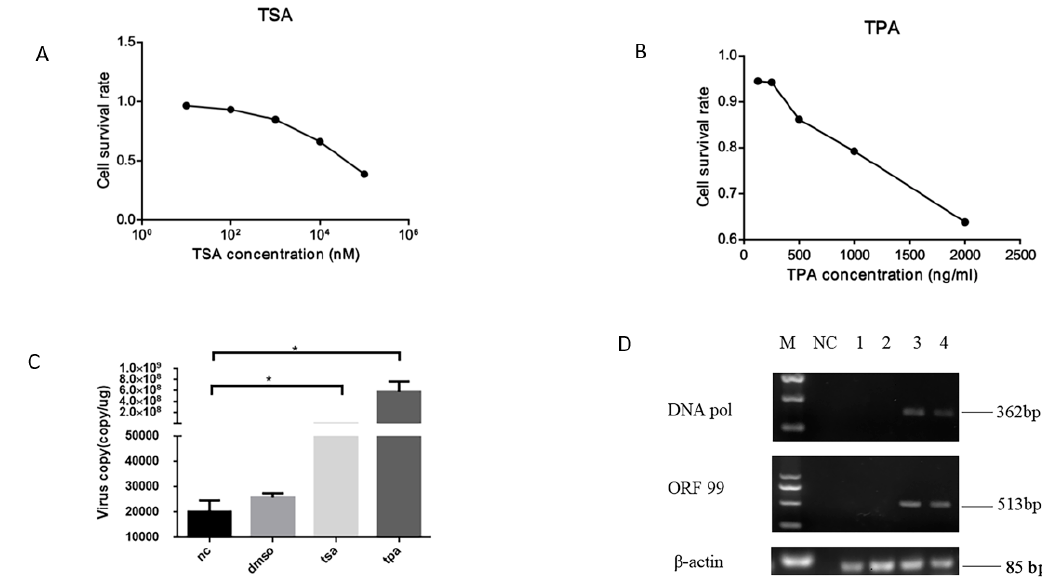
Figure 5. Examination of CyHV-2 DNA and gene transcription in GCBlat1 cells upon chemicals treatment: Cell viabilities of GCBlat1 cells were measured by an MTT assay following treatments with trichostatin A (TSA) ( A ) or phorbol 12-myristate 13-acetate (TPA) ( B ) (80, 40, 20, 10, and 5 µ M) or dimethyl sulfoxide (DMSO) for 48 h. ( C ) qPCR analysis of the CyHV-2 DNA from GCBlat1 cells with TSA, TPA, DMSO, or without treatment (nc). CyHV-2 DNA copies were calculated similarly as described above. Data presented as the mean ± SD ( n = 3). ( D ) RT-PCR analysis of total RNA harvested from treated and untreated GCBlat1 cells: The amplicons of DNA pol (362 bp) and ORF99 (513 bp) are indicated. The amplicons of β -actin gene are used as an internal control to ensure that comparable levels of input RNA were used in RT-PCR. M: DNA ladder; NC: negative control for PCR; lane 1: mock-treated GCBlat1 cells; lane 2: DMSO-treated GCBlat1 cells; lane 3: TPA-treated GCBlat1 cells; lane 4: TSA-treated GCBlat1 cells. One representative experiment of three is shown here. * p <